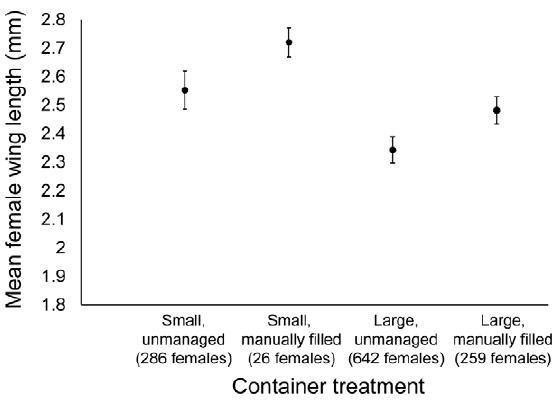
Figure 6. Adult size by container type. Mean ( 6 SE) wing length of females developing in four container